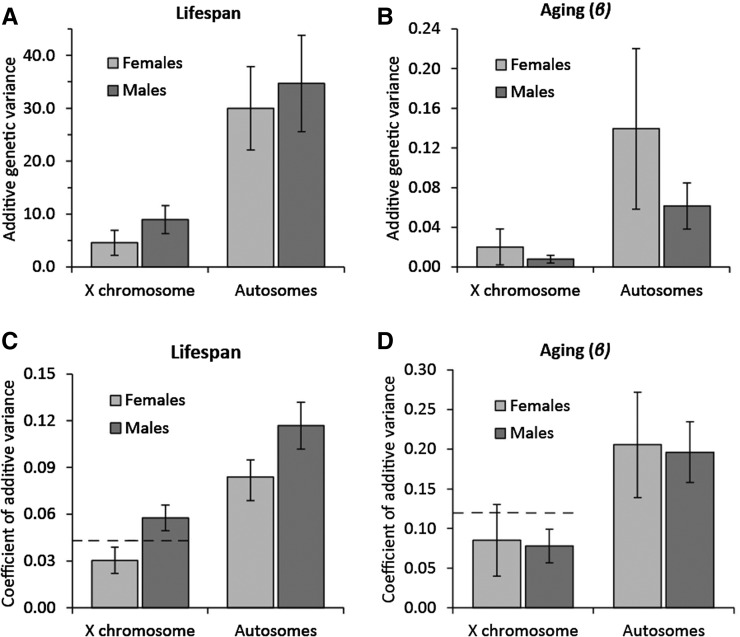
Additive genetic variance in lifespan and aging across chromosome types. Additive genetic variation in (A) lifespan and (B) aging (β × 100) for the X chromosome and the autosomes. The coefficient of additive genetic variation (CVA) for lifespan (C) and aging (D). Dashed lines indicate twice the X-linked female additive genetic variation on this scale. Error bars depict SE.